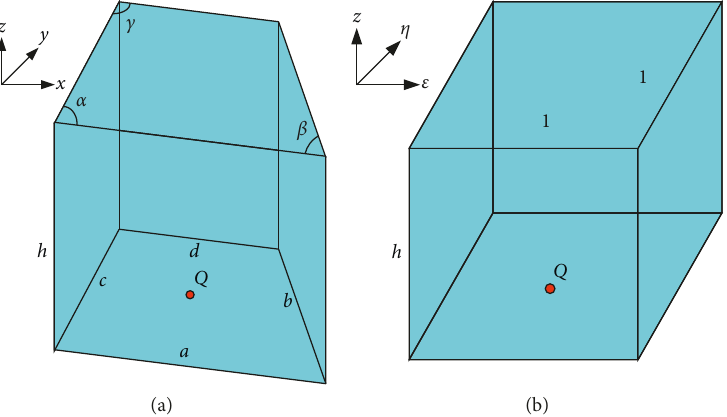
Figure 2: Arbitrary quadrangular prism acoustic cavity model and coordinate transformation. (a) The original coordinate system. (b) The new coordinate